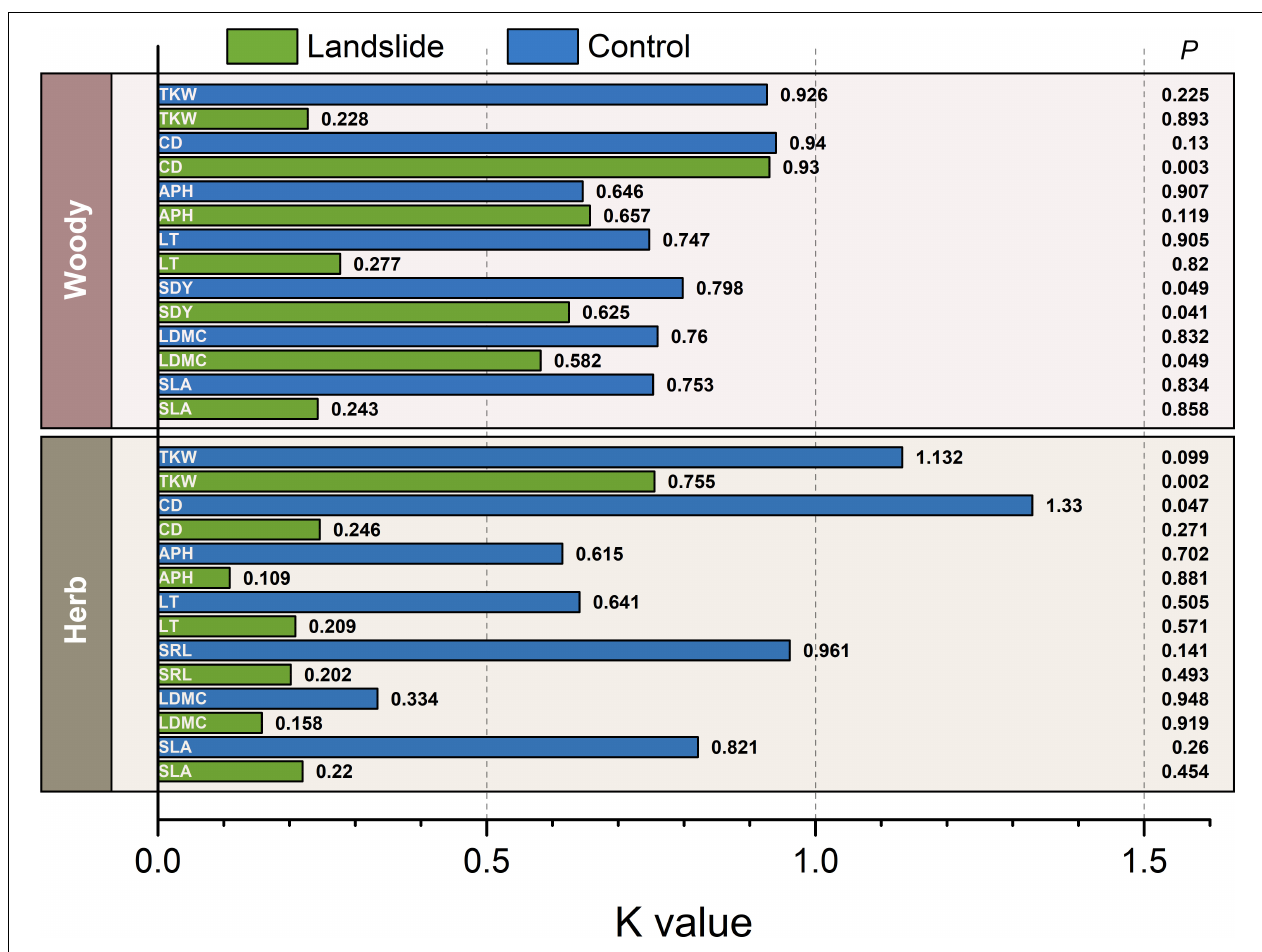
FIGURE 5 | Phylogenetic signals of plant functional traits in communities on landslides based on Blomberg’s K -value. SLA, specific leaf area; LDMC, leaf dry matter content; SRL, specific root length (for herbaceous plants only); SDY, stem density (for woody plants only); LT, leaf thickness; APH, average plant height; CD, crown diameter; TKW, thousand kernel